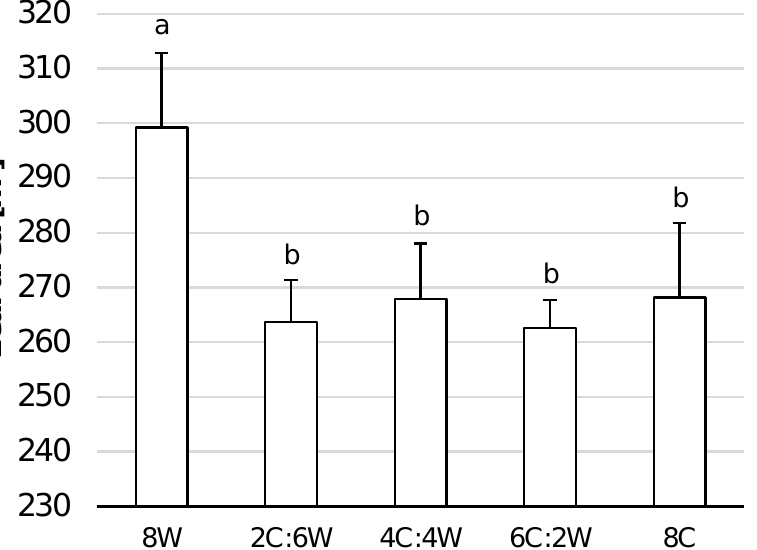
Figure 11. Effect of growing media ratio on leaf area (cm 2 ), 35 days after transplant. Vertical bars denote standard error. Different letters denote significant difference according to the Student’s t -test ( p ≤ 0.05).